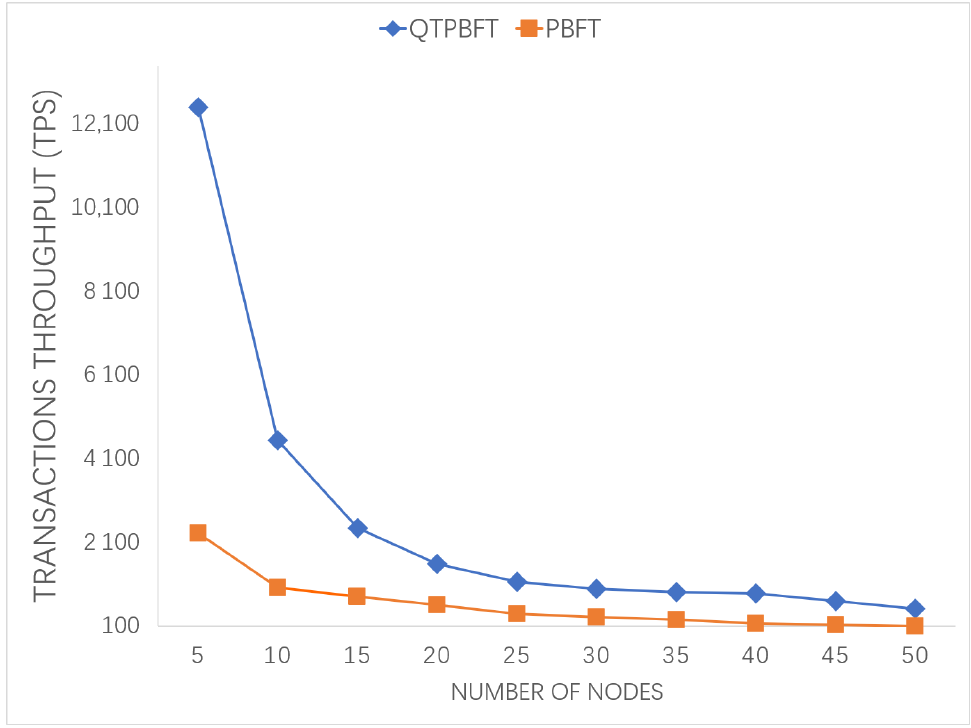
Figure 8. Comparison of the transaction throughput of the two algorithms.